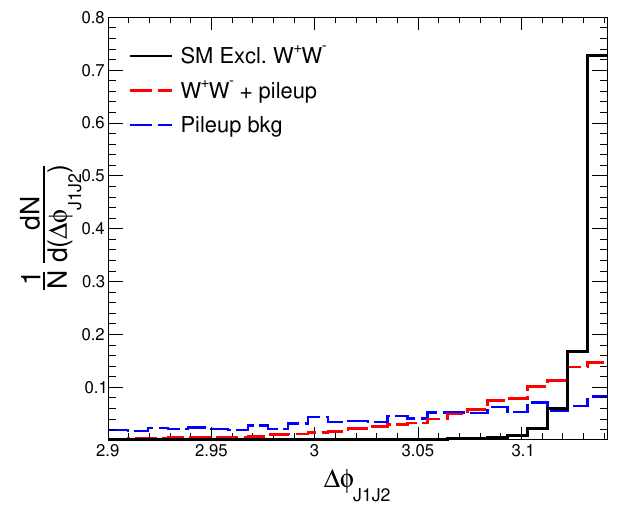
Figure 3 . Azimuthal angular difference between the two large-radius jets corresponding to the decay of the W bosons, ∆ φ j1j2 = | φ j1 − φ j2 | after preselection and m j1 and m j2 requirements. SM central exclusive W + W − events are represented by the black histogram, and non-diffractive W + W − +pileup background events are represented in red. The pileup background distribution (blue dashed histogram) is flatter due to the effect of initial-state radiation and underlying event activity in non-exclusive interactions. The distributions are normalized to unity.